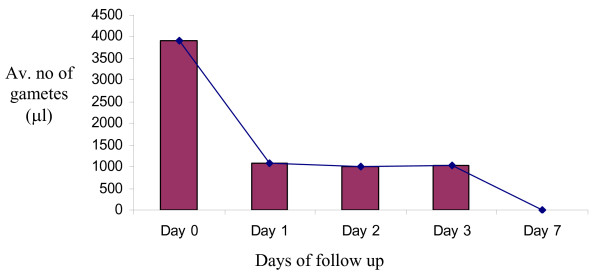
Gametocytemia after treatment.